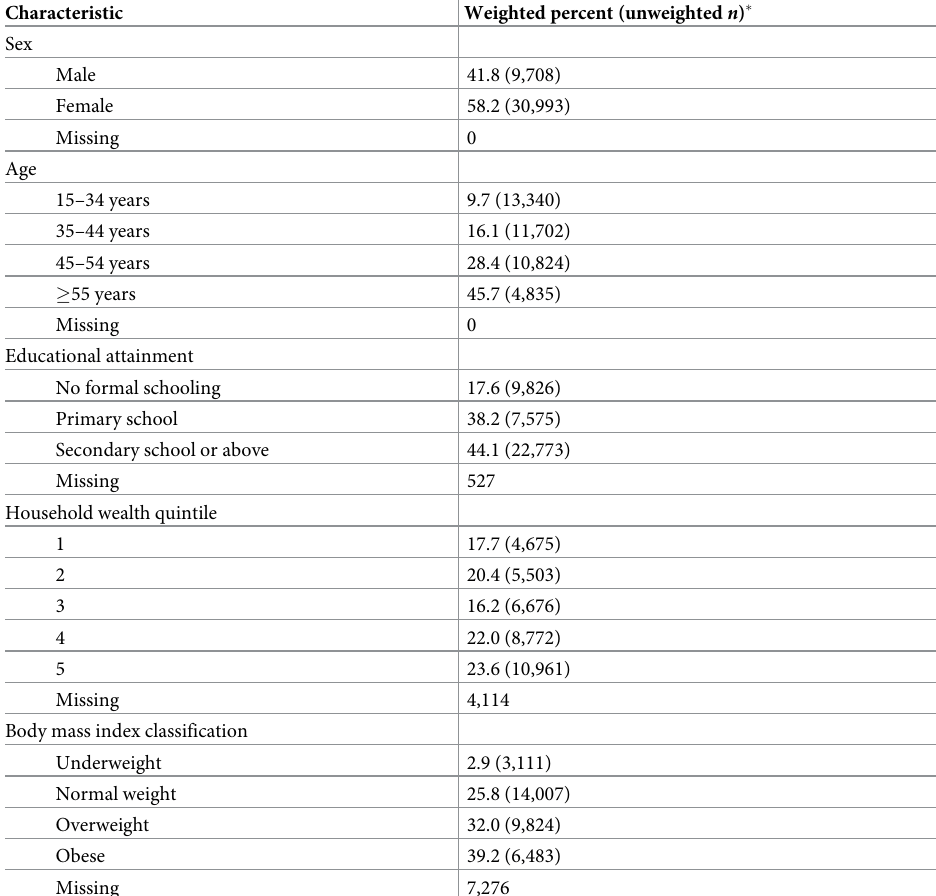
Table 2. Baseline characteristics of participants with diabetes ( n = 40,701) in population-based surveys conducted in 28 low- and middle-income countries between 2008 and 2016. Characteristic